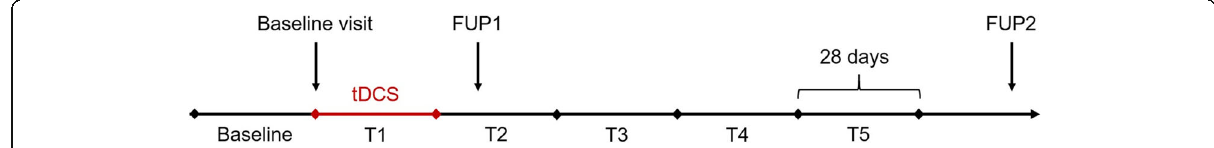
Fig. 1 Overview of the study design. The observation period was subdivided into six 28-day periods (Baseline, T1 – 5). The tDCS treatment was performed during T1 and was initiated immediately after the baseline visit. FUP1 was scheduled shortly after the end of the stimulation period and FUP2 after T5. Modified from Pohl et al.